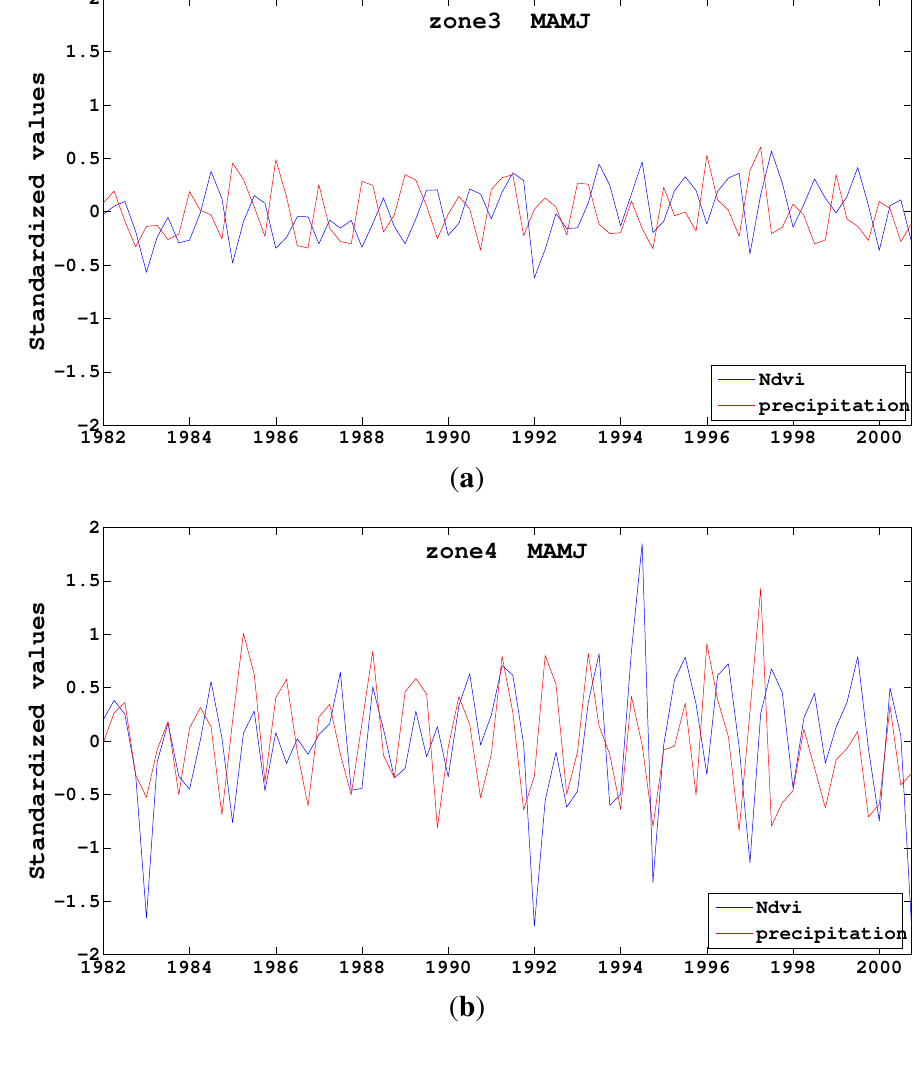
Figure 5. MAMJ (March, April, May, June) ( a , b ) and ASON (August, September, October, November) ( c , d ) seasonal variability of monthly averages of NDVI (blue solid line) and precipitation (red solid line) for the 1982–2000 period over bioclimatic ecoregion zones 3 (a,c) and 4